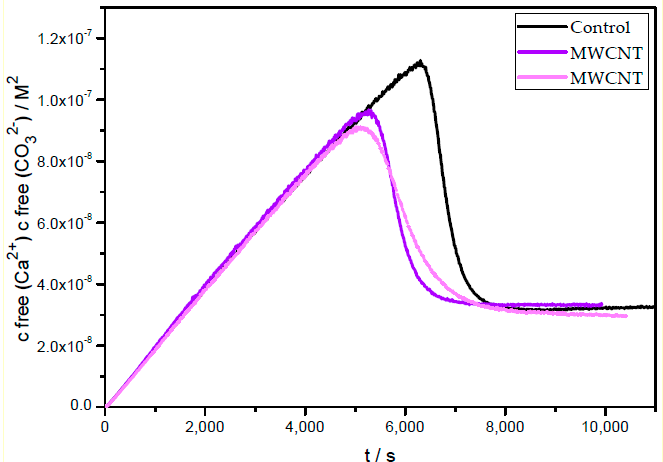
Figure 6. Time development of CaCO 3 solubility products using two concentration of MWCNT at pH 9.0: blank ( black line ), 2.5 mg/L MWCNT ( purple line ) and 7.5 mg/L MWCNT ( magenta line ).